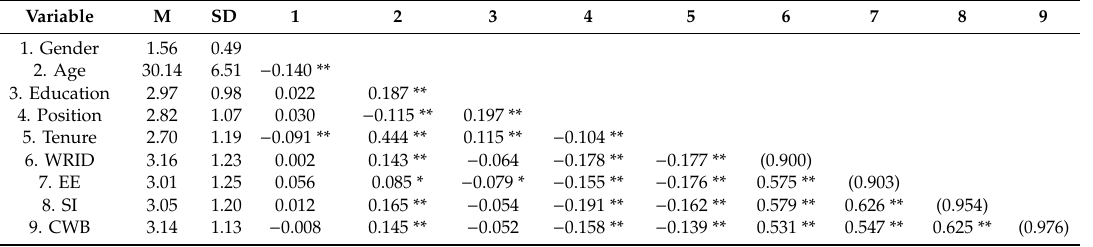
Table 1. The descriptive statistical analysis and correlations (N =